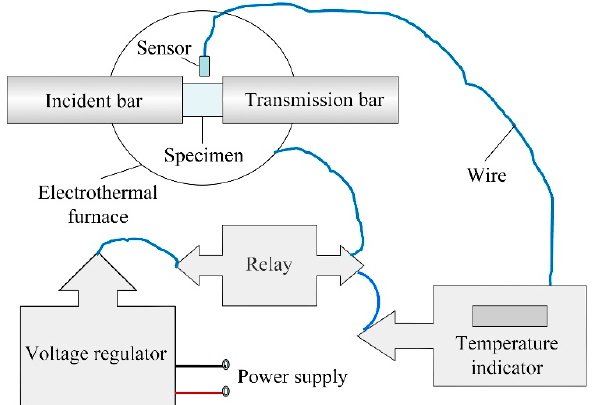
Figure 10. Principle diagram of high-temperature control system.